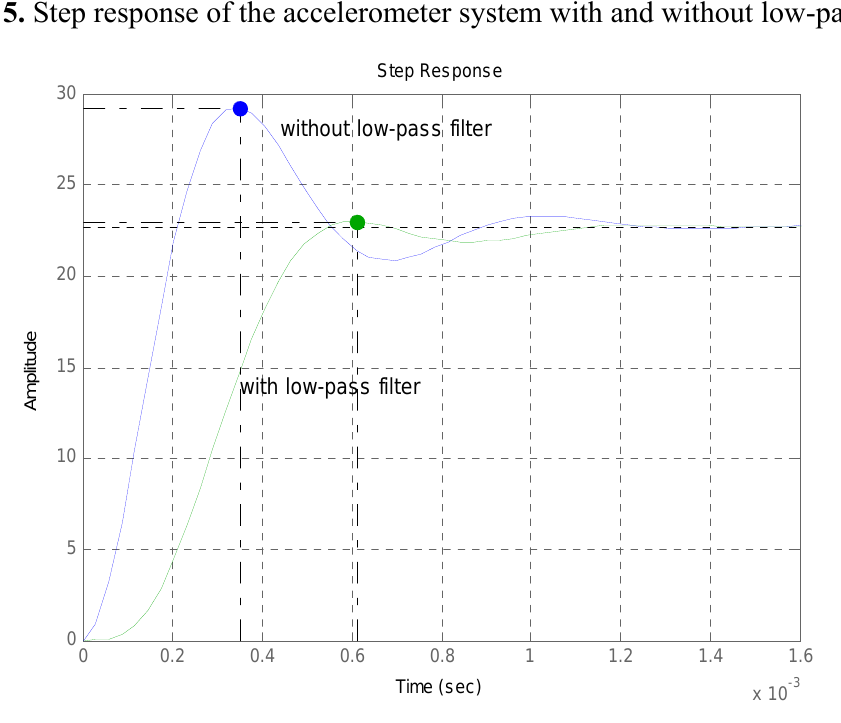
Figure 5. Step response of the accelerometer system with and without low-pass